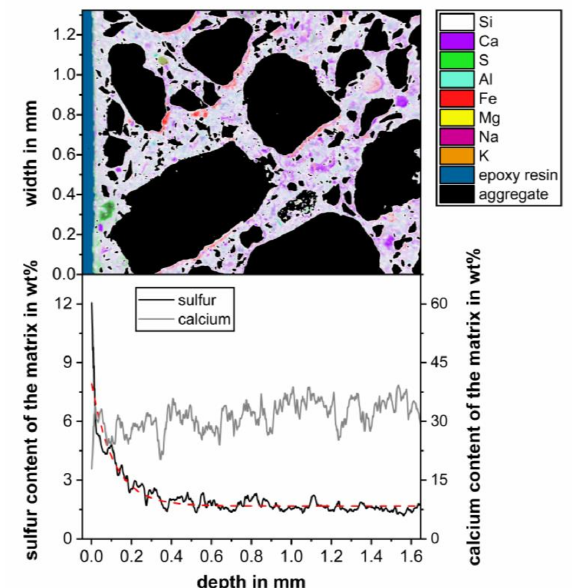
Figure 14. EDX map of a concrete sample with CEM I 42.5 N (w/c = 0.50) stored for 182 d at 5 ◦ C in Na 2 SO 4 solution with 6000 mg SO 4 2 − /L and corresponding depth